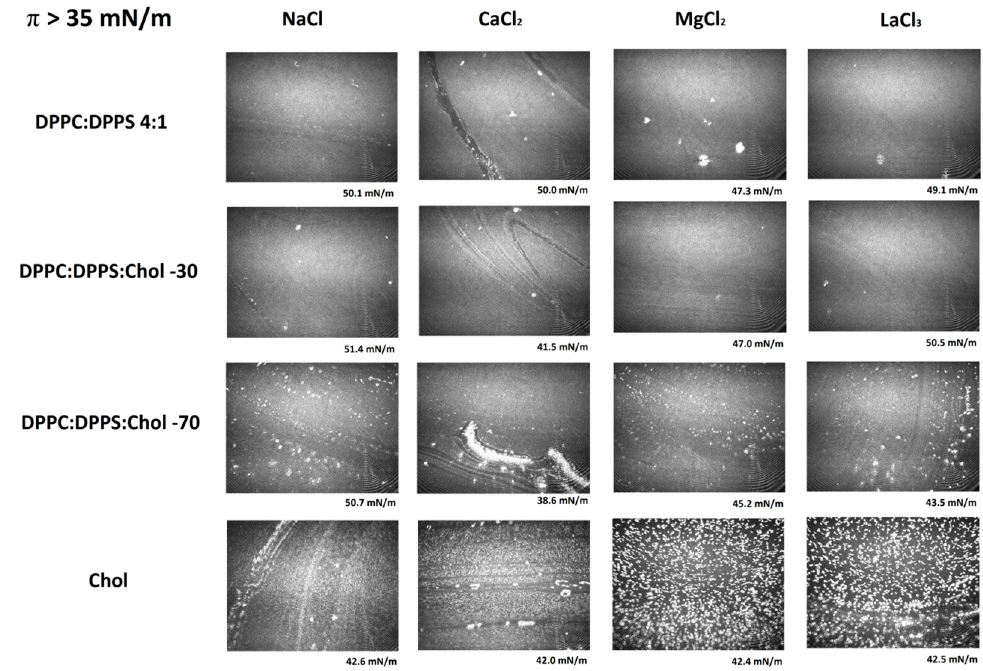
Figure 4. Micro-BAM images of the effect of electrolyte on DPPC:DPPS:CHOL monolayers at high compression states ( π > 35 mN/m). The images correspond to the π -A isotherms plotted in Figure 1.